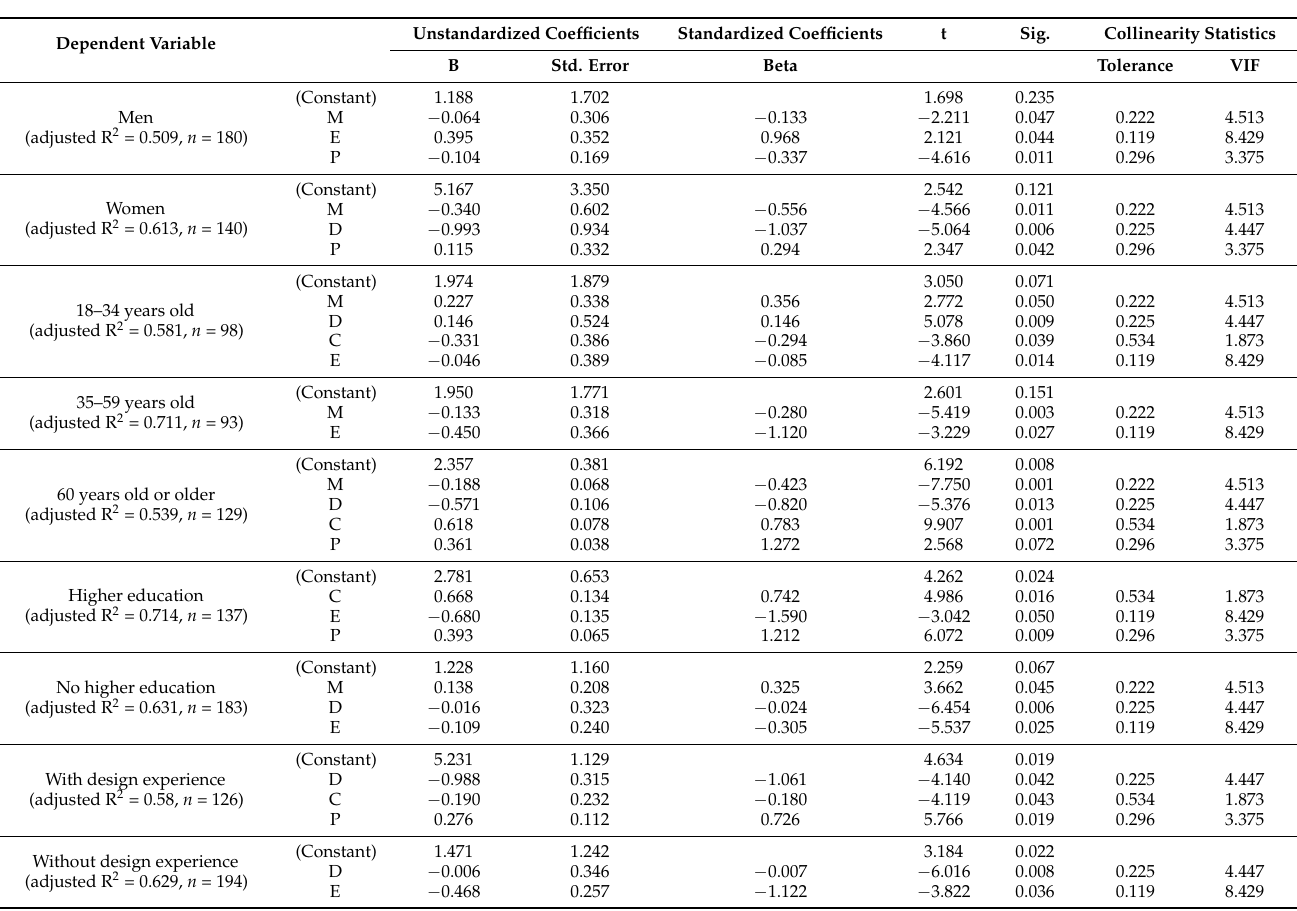
Table 9. Linear regression analysis of physical features of the photos for respondents with different demographic